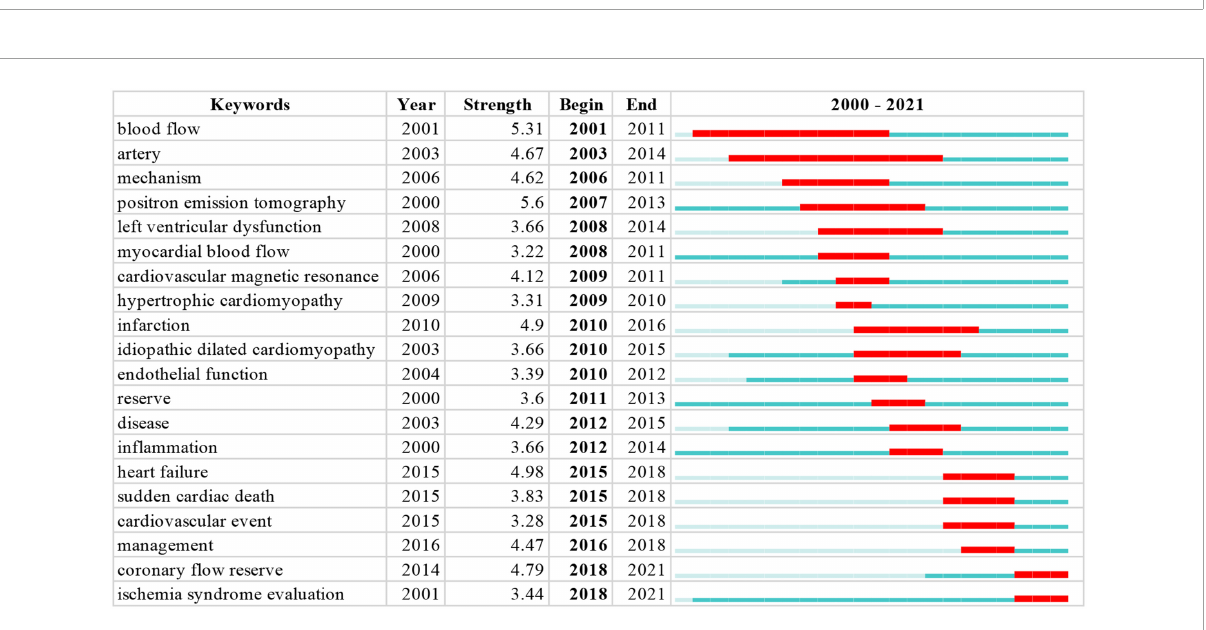
FIGURE6 Top 20 Keywords with the strongest citation bursts. The blue indicates the timeline. The red segment indicates the start year, end year, and duration of the